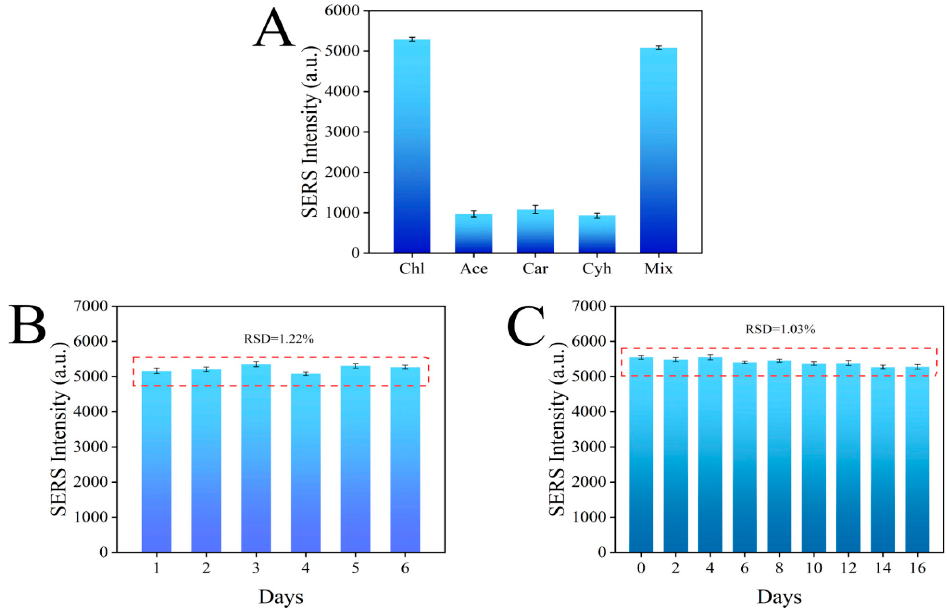
Figure 10. Specificity ( A ), reproducibility ( B ), and stability ( C ) of the aptamer sensor for chlorpyrifos detection.